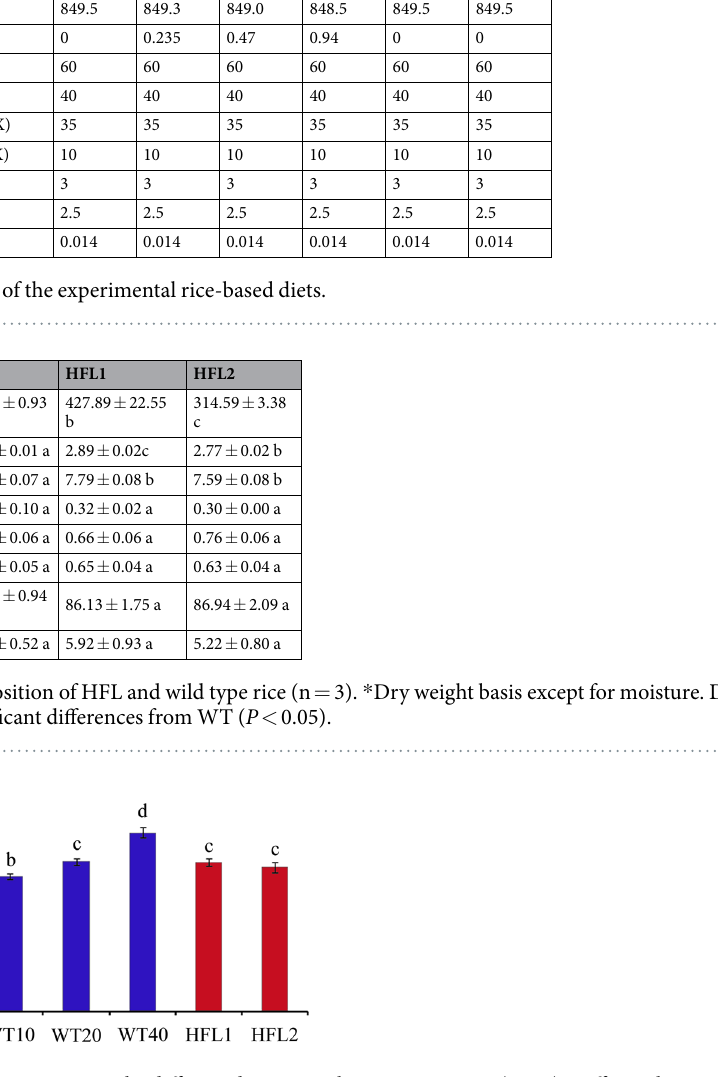
Figure 1. Lysine concentrations in the different diets. Error bars represent SD (n = 3). Different letters represent significant differences ( P <